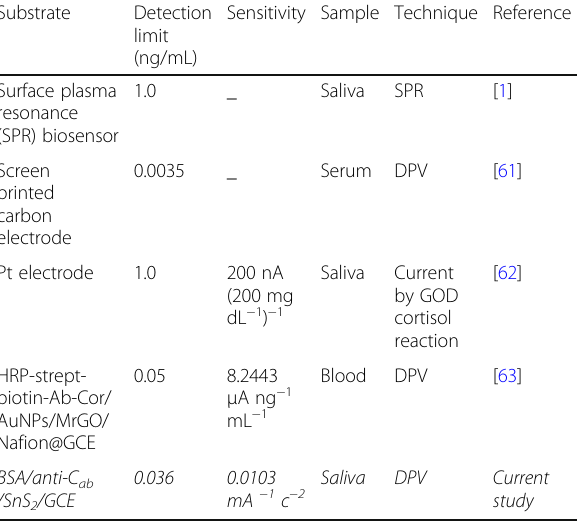
Table 2 Comparisons of modified non-gold electrodes to the cortisol detection results reported in the literature and in the present study